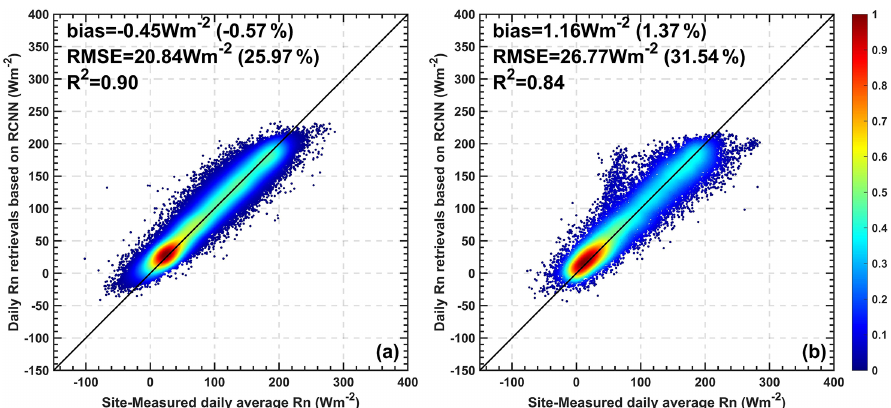
Figure 5. Scatterplots of (a) model training (fitting) accuracy and (b) model test accuracy for the reliable training and independent validation sites. The color bar illustrates the normalized density of samples.